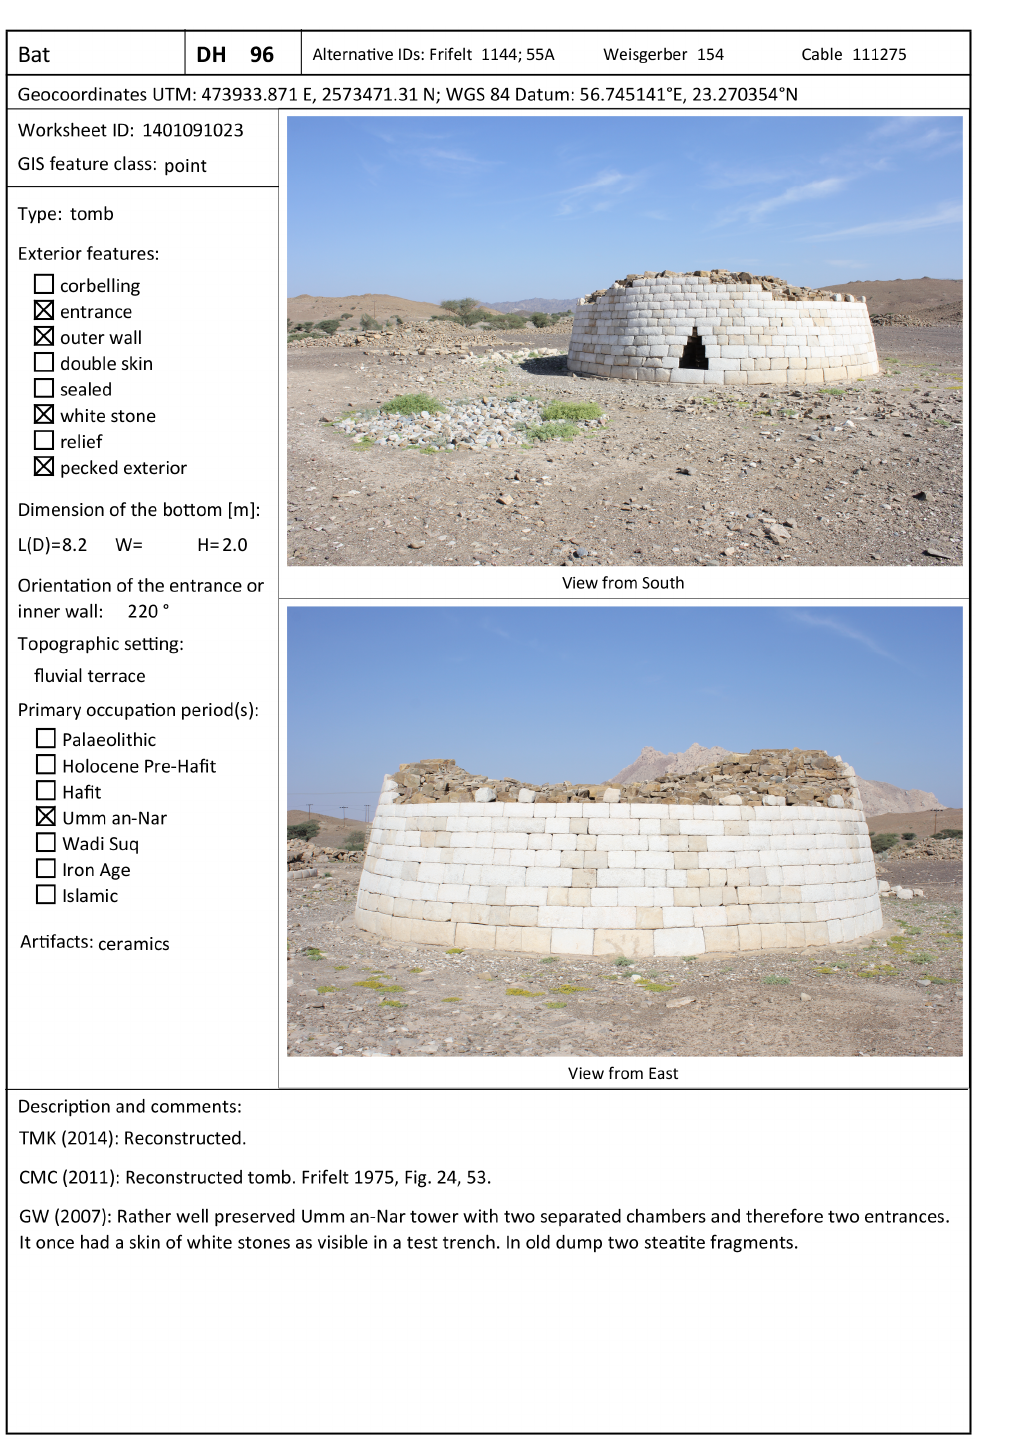
Figure 11: An example of the report of a feature exported from the BatDHI FileMaker